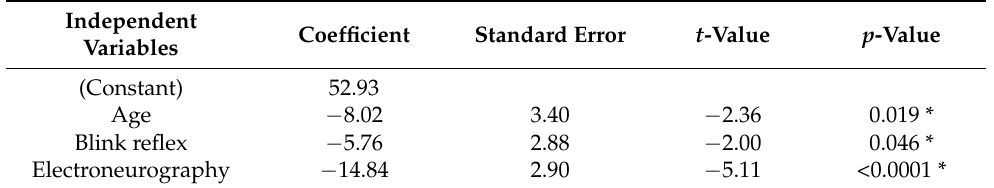
Table 3. Multivariable regression analysis for recovery time (days) in patients with idiopathic Bell’s palsy ( n =